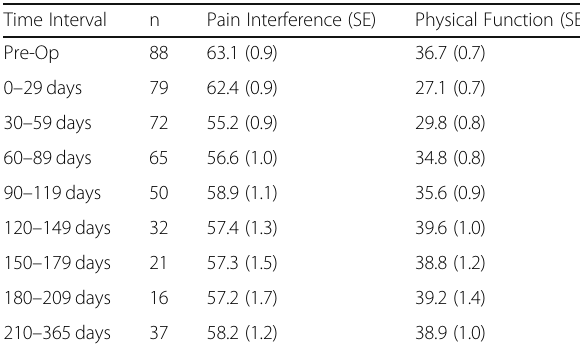
Table 4 Mean and standard error of the mean a (SE) for pain interference and physical function for each time point using all participants data ( n =